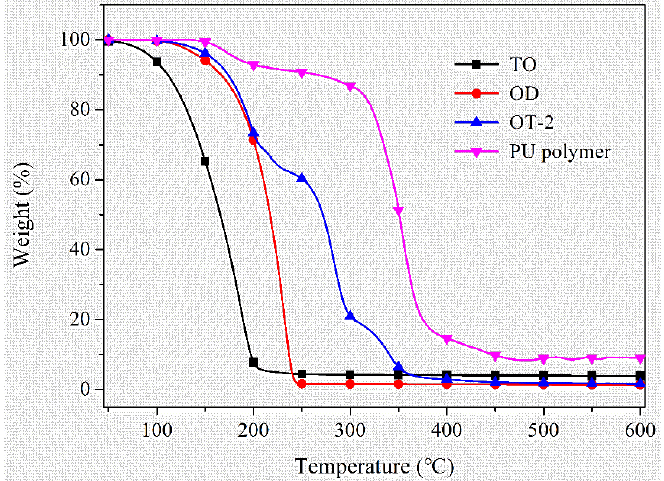
Figure 5. Thermal gravimetric analyzer (TGA) curves of TO, OD, composite microcapsules (sample OT-2) and PU polymer.